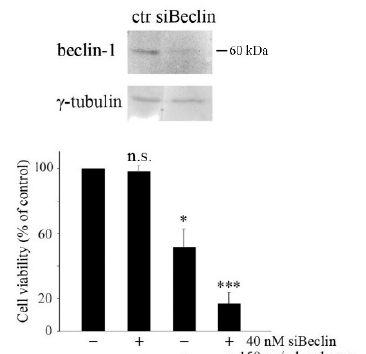
Figure 7. Beclin silencing counteracts the cytotoxic effects of litchi extracts. After silencing, siRNA against beclin-1 (siBeclin) and scramble control transfected cells were subjected to western blot analysis to verify beclin-1 silencing. An MTT assay was performed after treating transfected cells with litchi endocarp extracts. All histograms shown are representative of three independent experiments. (*) p < 0.05; (***) p < 0.001 compared with control.